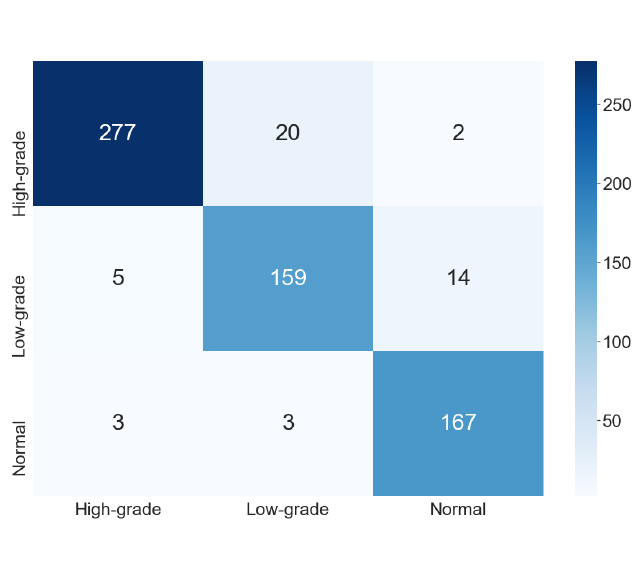
Figure 6. Confusion matrix for the three-class classification.